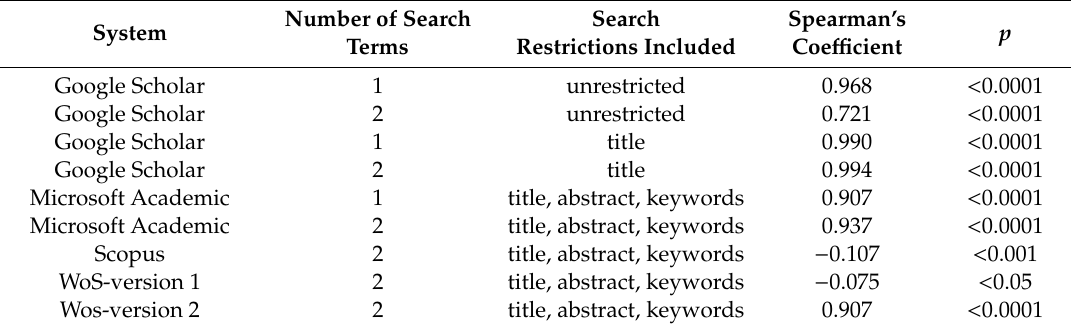
Table 2. Correlation coe ffi cients for the academic search